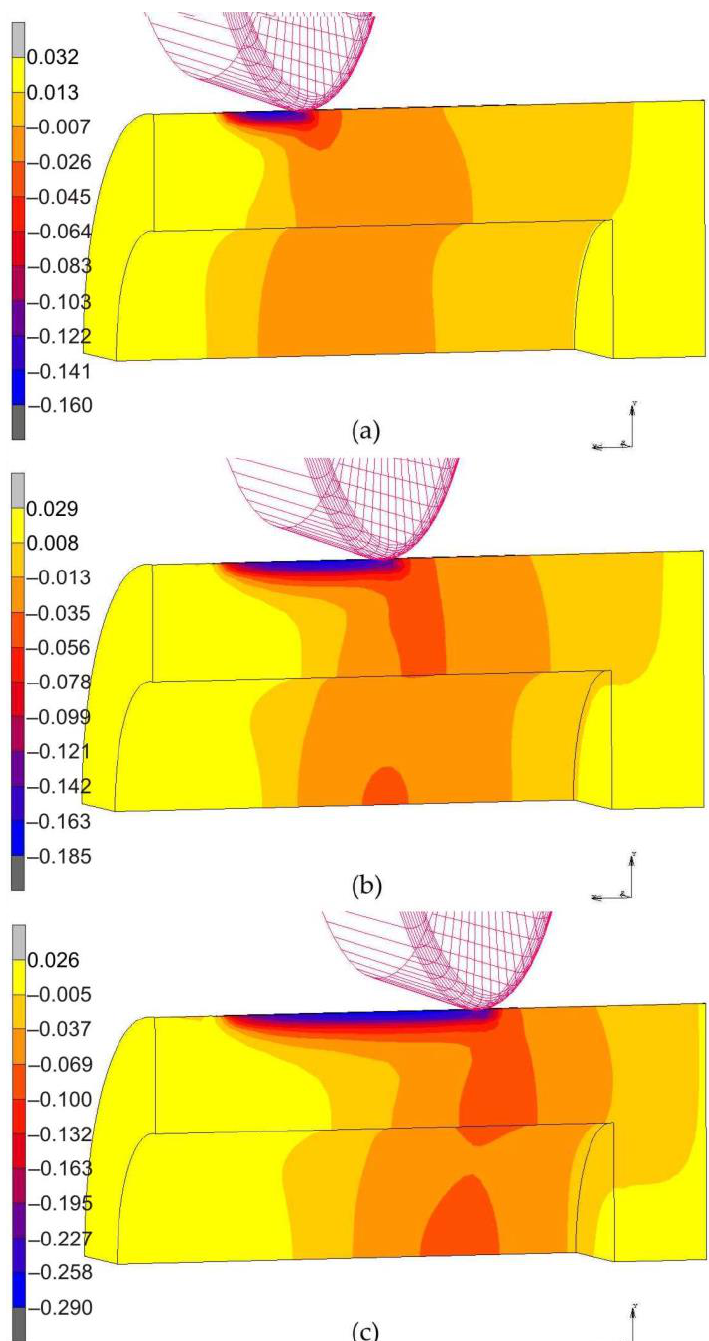
Figure 19. Displacement of the material in the x-direction during roller burnishing without braking moment across the width of the rings packet at a distance of: ( a ) 10 mm, ( b ) 20 mm and ( c ) 30 mm.